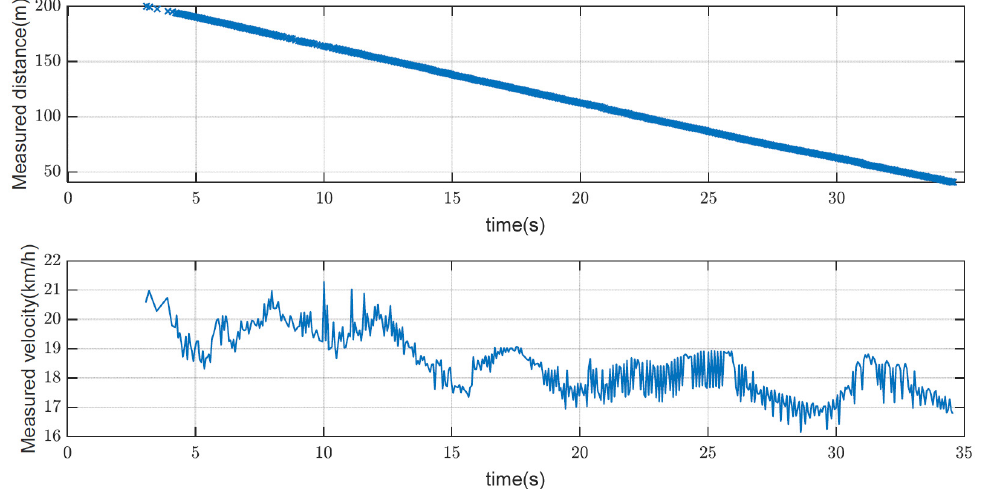
Figure 19. Measured distance and velocity when approaching at 20